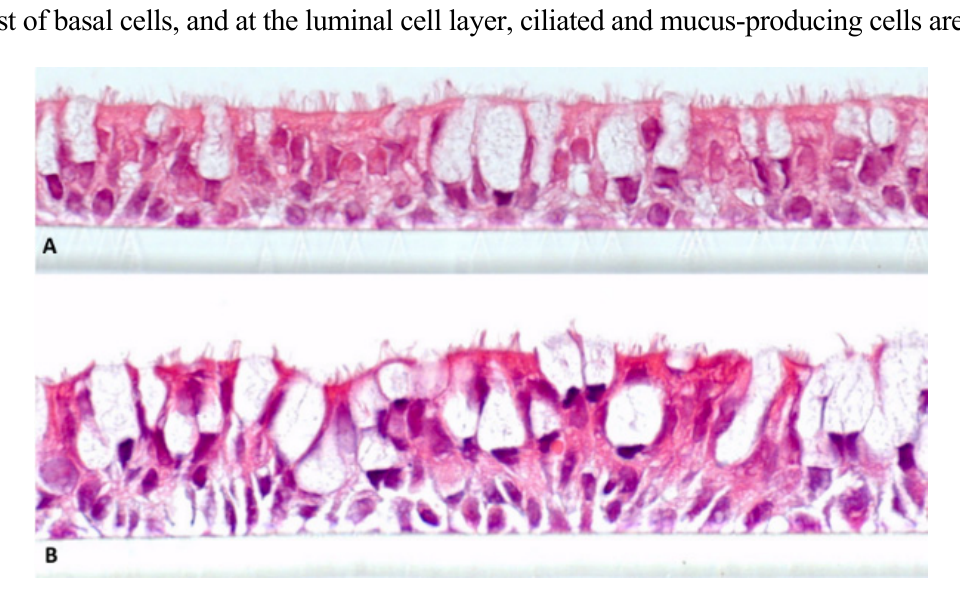
Figure 3. Cell cultures differentiated at the air-liquid interface for 21 days. ( a ) Primary normal human bronchial epithelial cells NHBE48; ( b ) Immortalized normal human bronchial epithelial cells (CL-1548). Magnification 630 ×